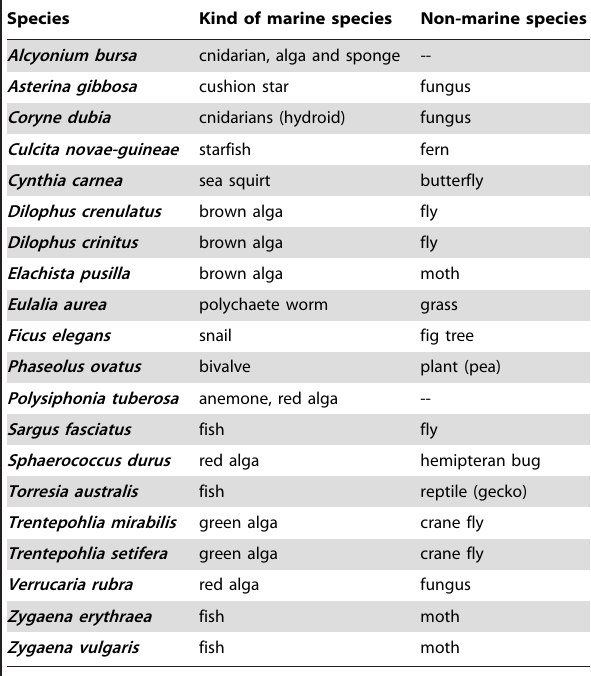
Table 1. Examples of the same names being used for different species (including a marine species) found by Rees